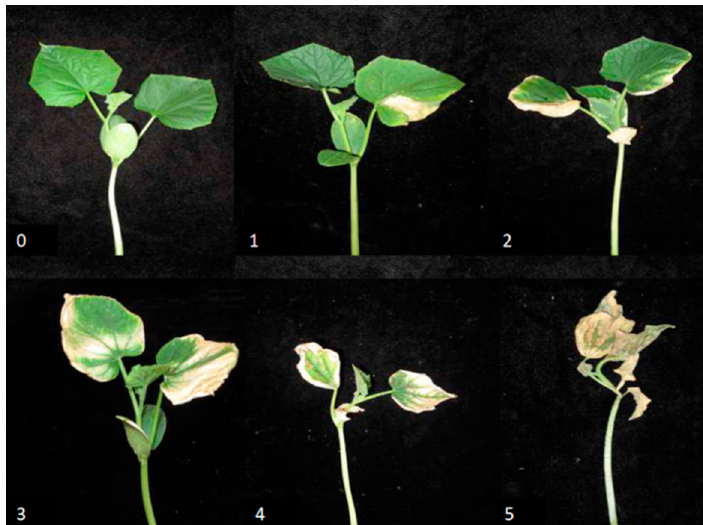
Figure 1. Phenotypic characterization of thermotolerance in cucumber seedlings. Heat injury index (HII) was used to indicate thermotolerance based on the dehydration of the two mature leaves and young leaf. 0: no symptoms on both the mature and young leaves; 1: the young leaf has no symptoms, while less than 1/3 of the mature leaves were dehydrated; 2: the young leaf has few dehydrated spots, while 1/3–2/3 of the mature leaves were dehydrated; 3: less than 1/2 of the young leaf was dehydrated, while more than 2/3 of the mature leaves were dehydrated; 4: more than 1/2 of the young leaf was dehydrated, and more than 2/3 of the mature leaves were dehydrated; 5: both the young and mature leaves were dehydrated. Table 1. Frequency distribution of HII in recombinant inbred lines (RILs) and double haploid (DH)